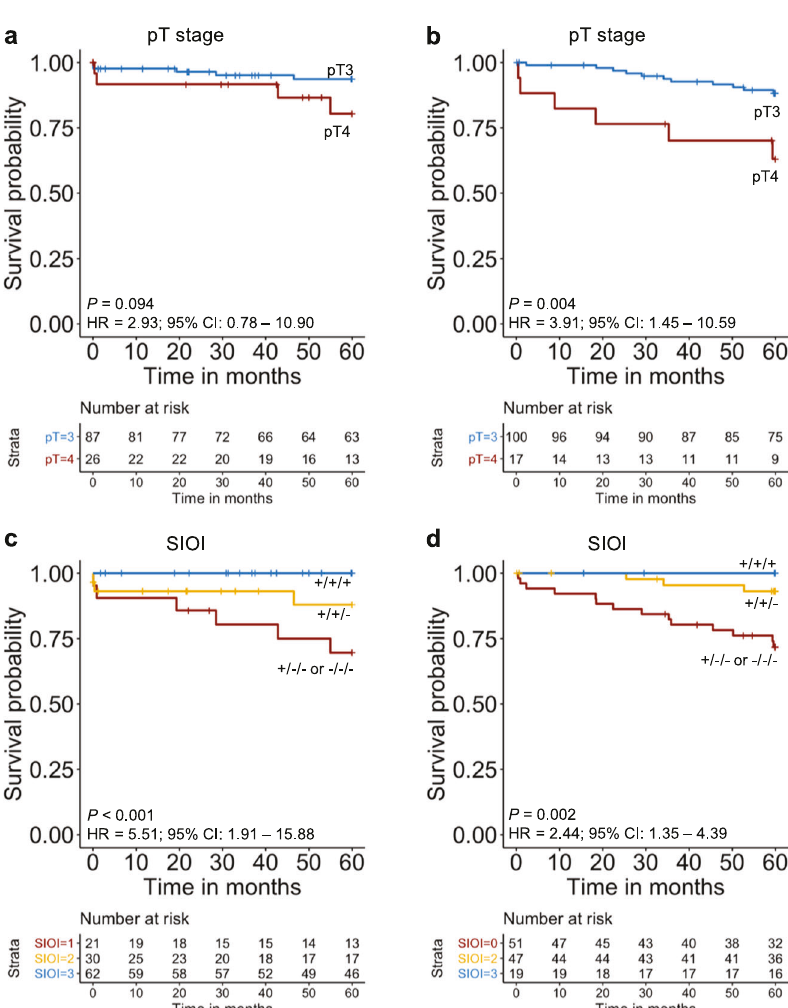
Fig. 5 KM survival analysis for pT stage and SIOI for training cohort (5-year follow-up) and validation cohort (5-year follow-up). a pT stage for training cohort. b pT stage for validation cohort. c SIOI for training cohort. d SIOI for validation cohort. The “ + / + / + ” category represents the group of patients who have CD3 + density in the IMCT above the cutoff point (389.6 cells/mm 2 ), average CD3 + CD8 + number within 0 – 50- μ m of TB above the cutoff point (4.1) and CD68 + /CD163 + ratio in the CT below the cutoff point (1.096); “ + / + / − ” group represents patients who are positive for only two of these features and “ + / − / − or − / − / − ” represents the group of patients who have only 1 or none of the above features. The HR is calculated using univariate Cox